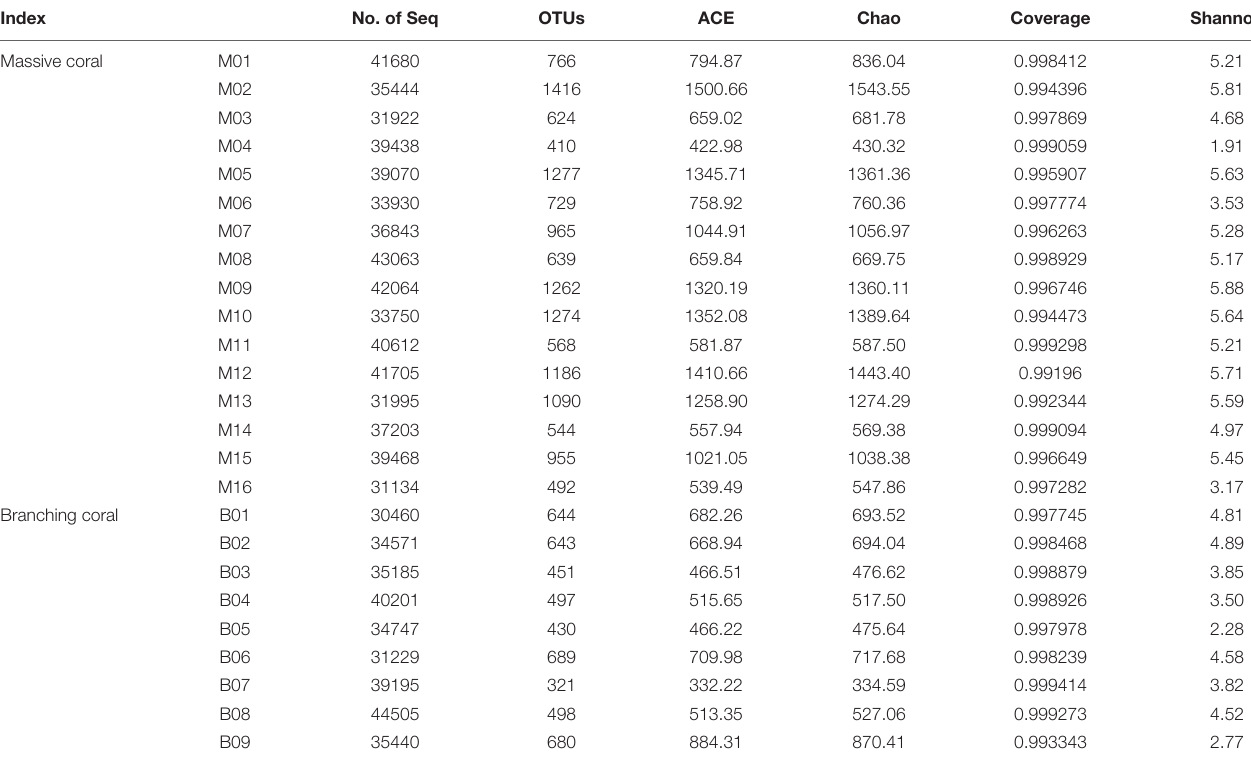
TABLE 2 | Numbers of sequences and operational taxonomic units (OTUs) (97%) and diversity estimates of bacteria associated with different morphologic corals. Index Coverage